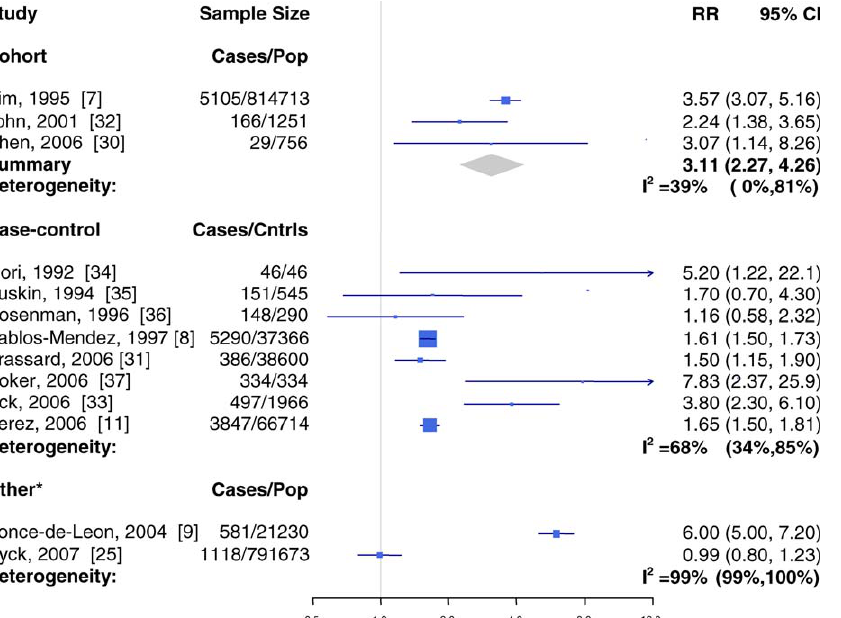
Figure 2. Forest Plot of the 13 Studies That Quantitatively Assessed the Association between Diabetes and Active Tuberculosis by Study Designs Size of the square is proportional to the precision of the study-specific effect estimates, and the bars indicate the corresponding 95% CIs. Arrows indicate that the bars are truncated to fit the plot. The diamond is centered on the summary RR of the cohorts studies, and the width indicates the corresponding 95% CI. *Other: The studies by Ponce-de-Leon et al. [7] and Dyck et al. [25] were not specified as prospective cohort or case-control. TB case accrual occurred prospectively, while the underlying distribution of diabetes was determined during a different time period after baseline.